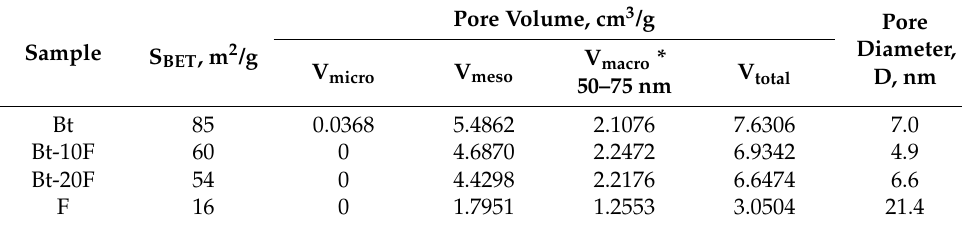
Table 2. Specific surface area and porosity of Bt, CoFe 2 O 4 and composites on their base.